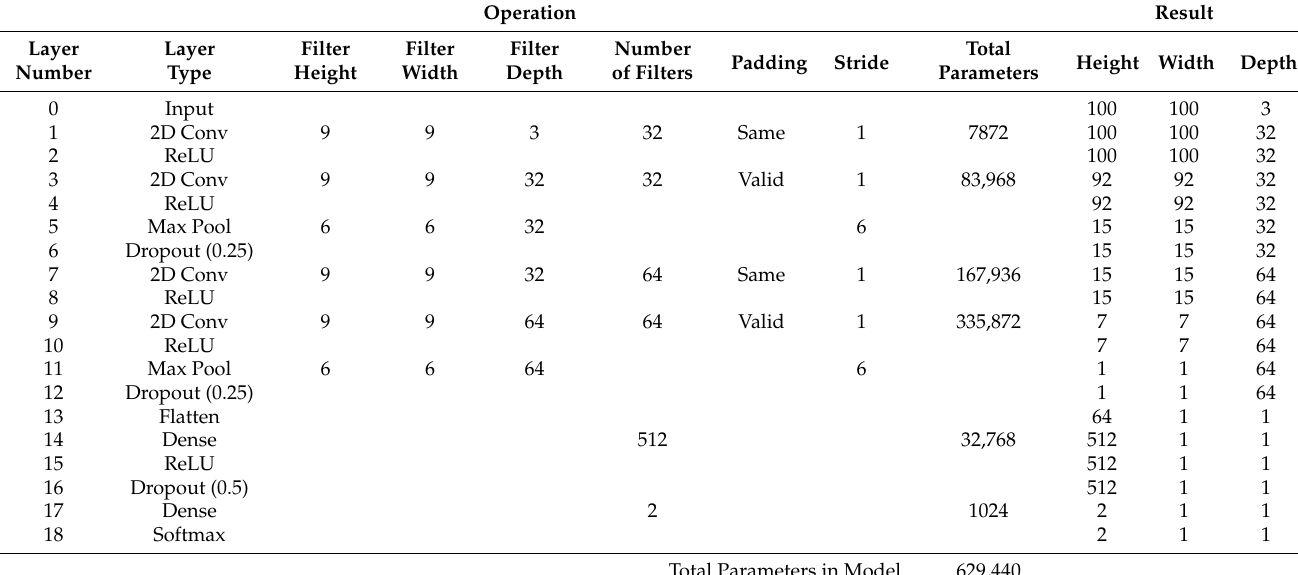
Table 3. Details of CNN Architecture C, inspired by the CIFAR example in Keras